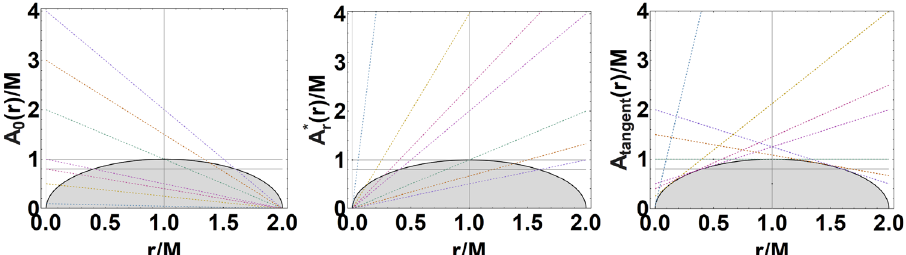
are also shown. Second panel: black region is the BH on the extended on plane, the gray region contains negative values of frequencies (corre- H sponding to retrograde motion or a < 0). The maximum values of σ < σ p x are also shown. Third panel: maximum values of for positive and negative a are shown as functions of r / M . The value σ descr as in Eq. (60) and Fig. 16 is also shown. Fourth and fifth panels: planes σ p = constant and σ x = constant for ( a / M , r > r + )